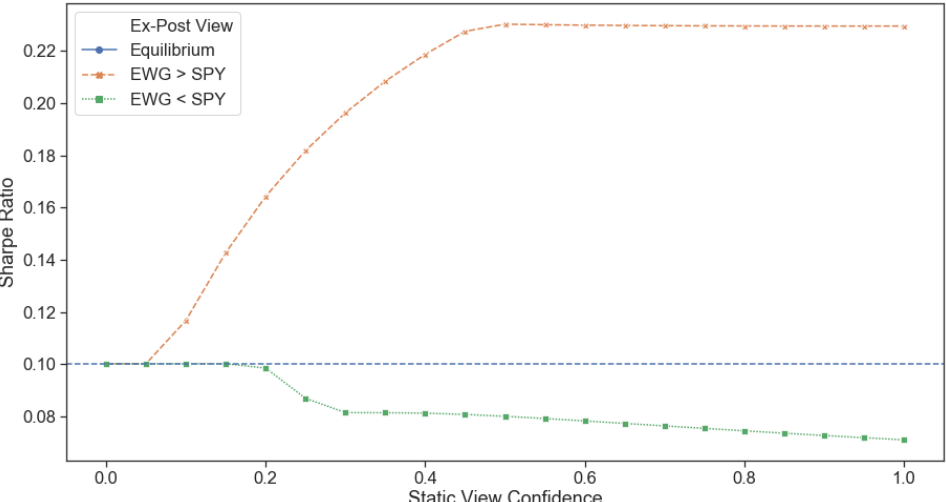
Figure 7. Static View Confidence: Portfolio Weights.